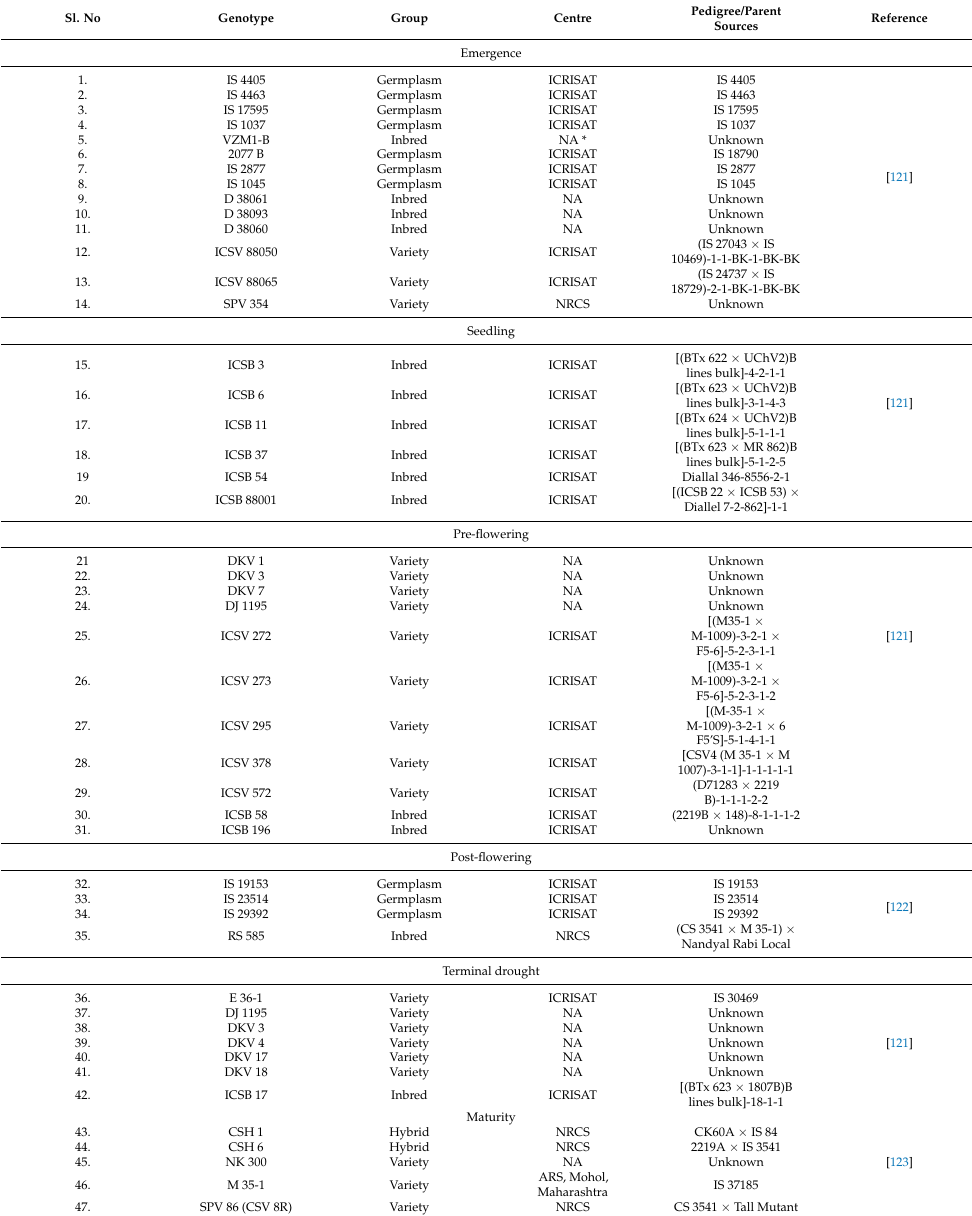
Table 2. Germplasm identified for drought stress tolerance at the International Crops Research Institute for the Semi-Arid Tropics (ICRISAT),